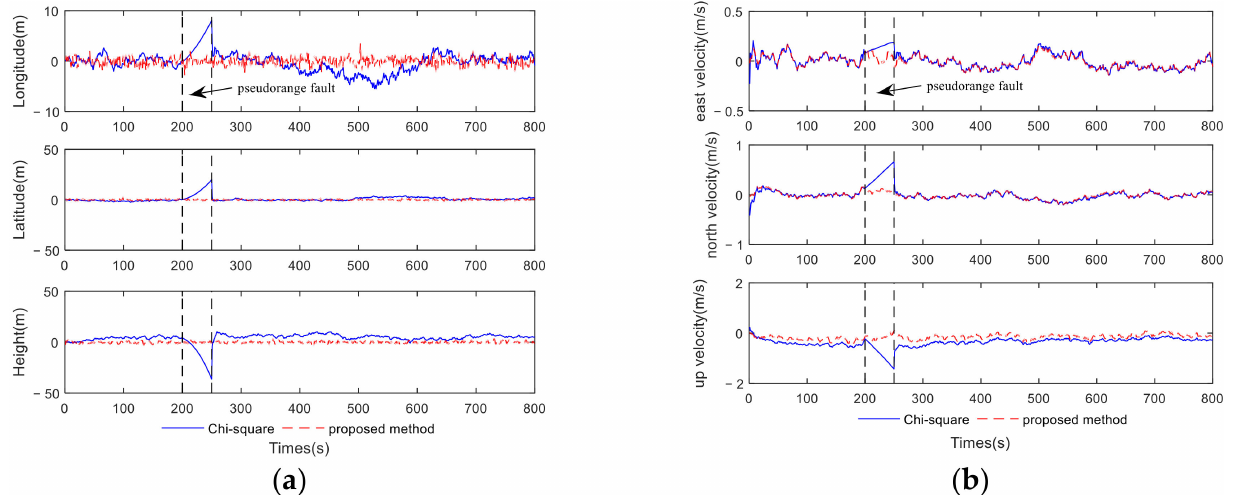
Figure 6. The fusion states errors under the single-satellite step fault: ( a ) position errors; ( b ) velocity